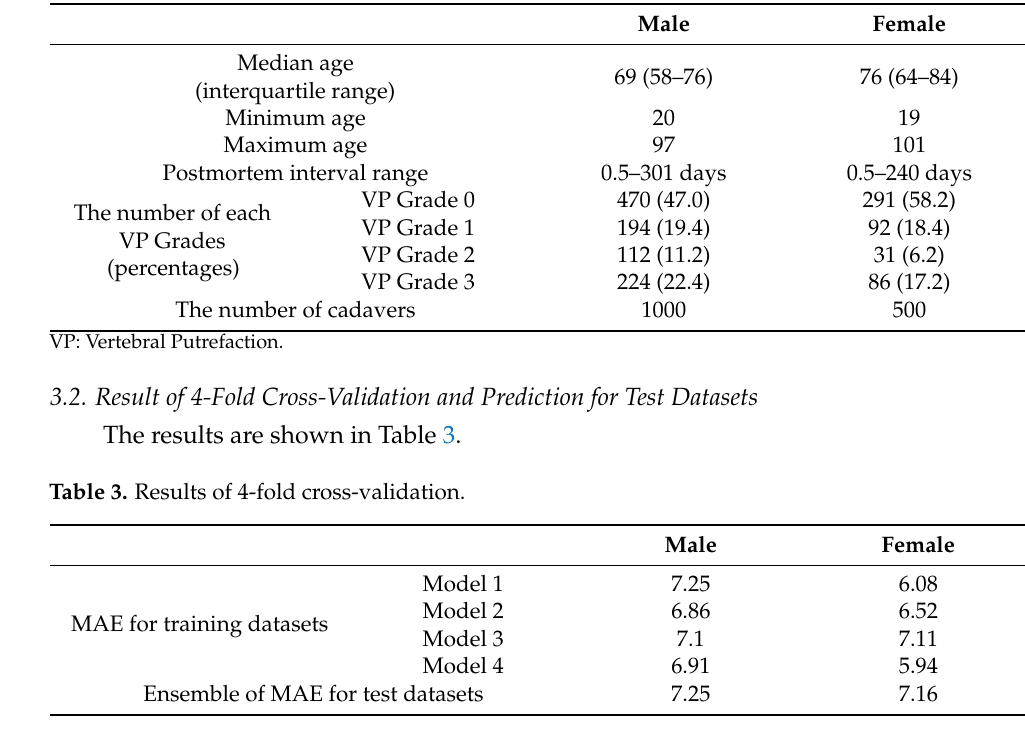
Table 2. Characteristics of cadavers.